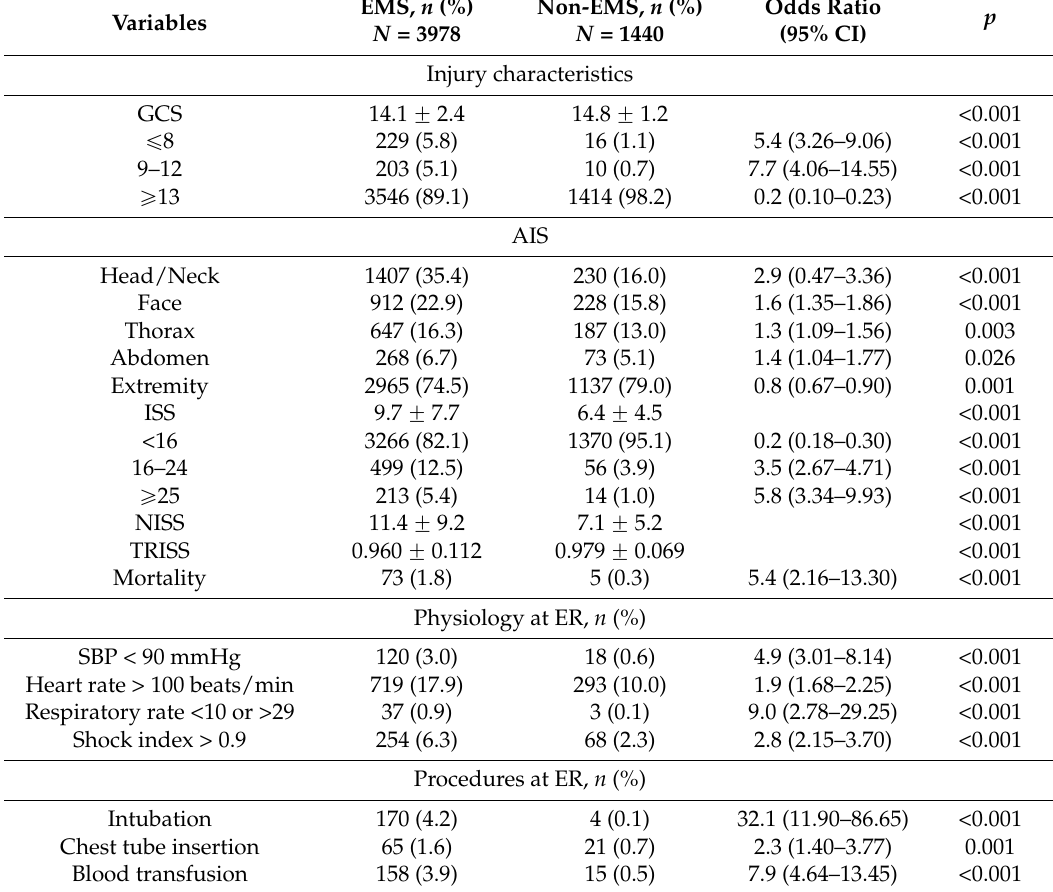
Table 3. Injury characteristics, physiological status on arrival, and procedures performed at the emergency department of patients transported by Emergency Medical Services (EMS) and non-EMS.